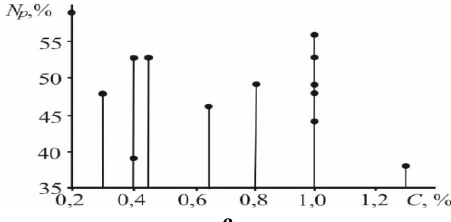
c Figure 4. The degree (a) and non-uniformity (b, c) of the illumination of the photographic material when exposing samples of differing in carbon content (see table 1)